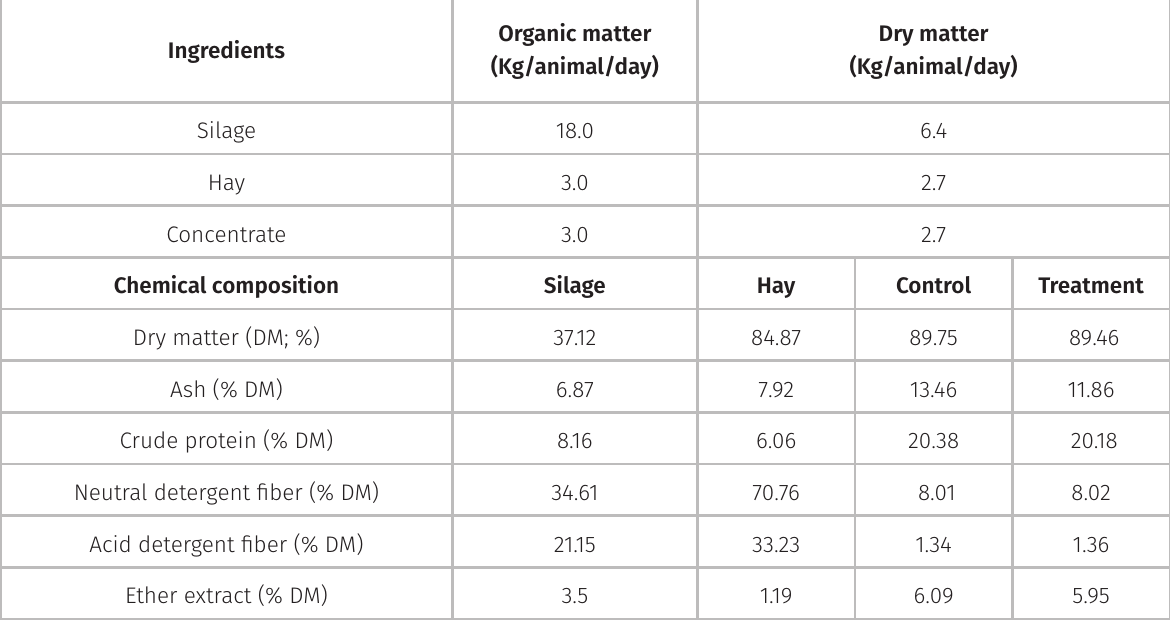
Table I. Feed and chemical composition of the diets prepartum.